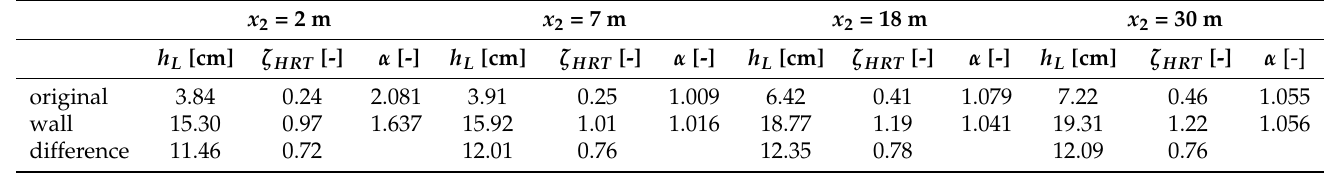
Table 2. Evaluation of the local head loss h L , local head loss coefficient ζ HR with a reference velocity defined at the upstream connecting headrace tunnel (HRT) and the kinetic energy flux coefficient α of the downstream cross section depending on the distance x 2 for the original geometry in comparison with the submerged wall—constant discharge of 7.079 m 3 /s.